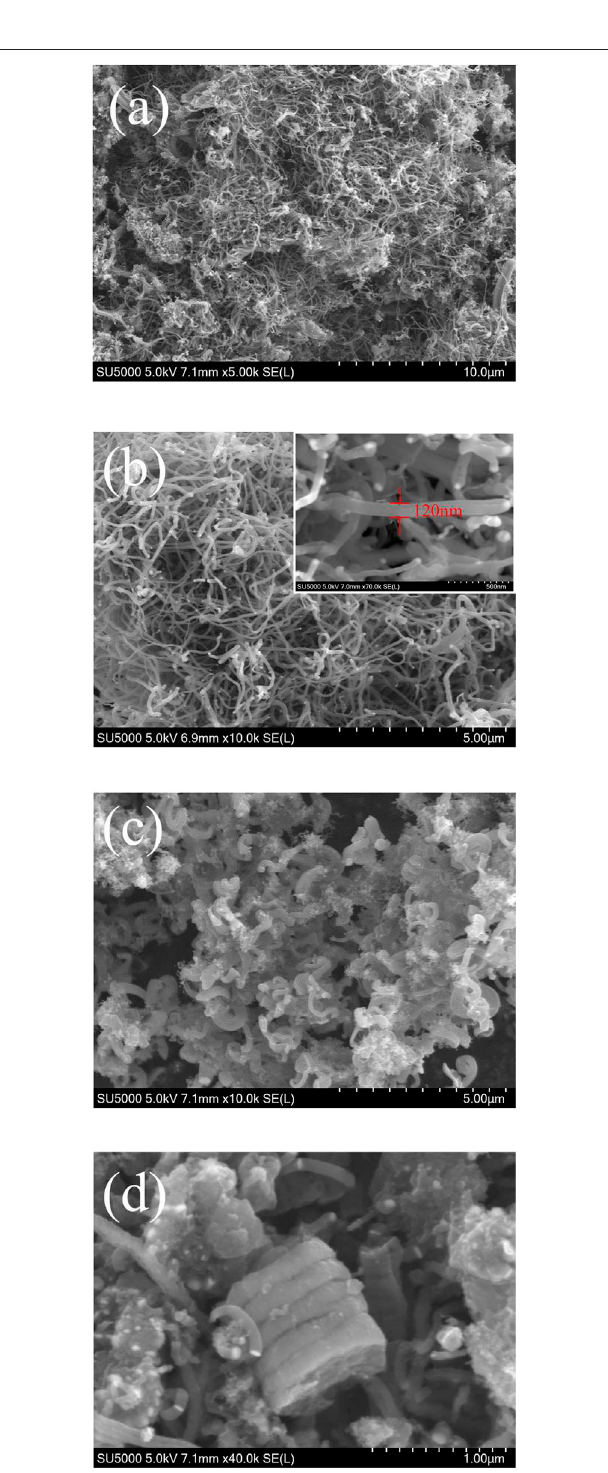
FIGURE 1 | (A,B) SEM images of MWCNTs at different magni fi cations. (C) SEM images ofthe V 2 O 5 /MWCNT composite material. (D) SEM images of the nitrogen-doped V 2 O 5 /MWCNT composite